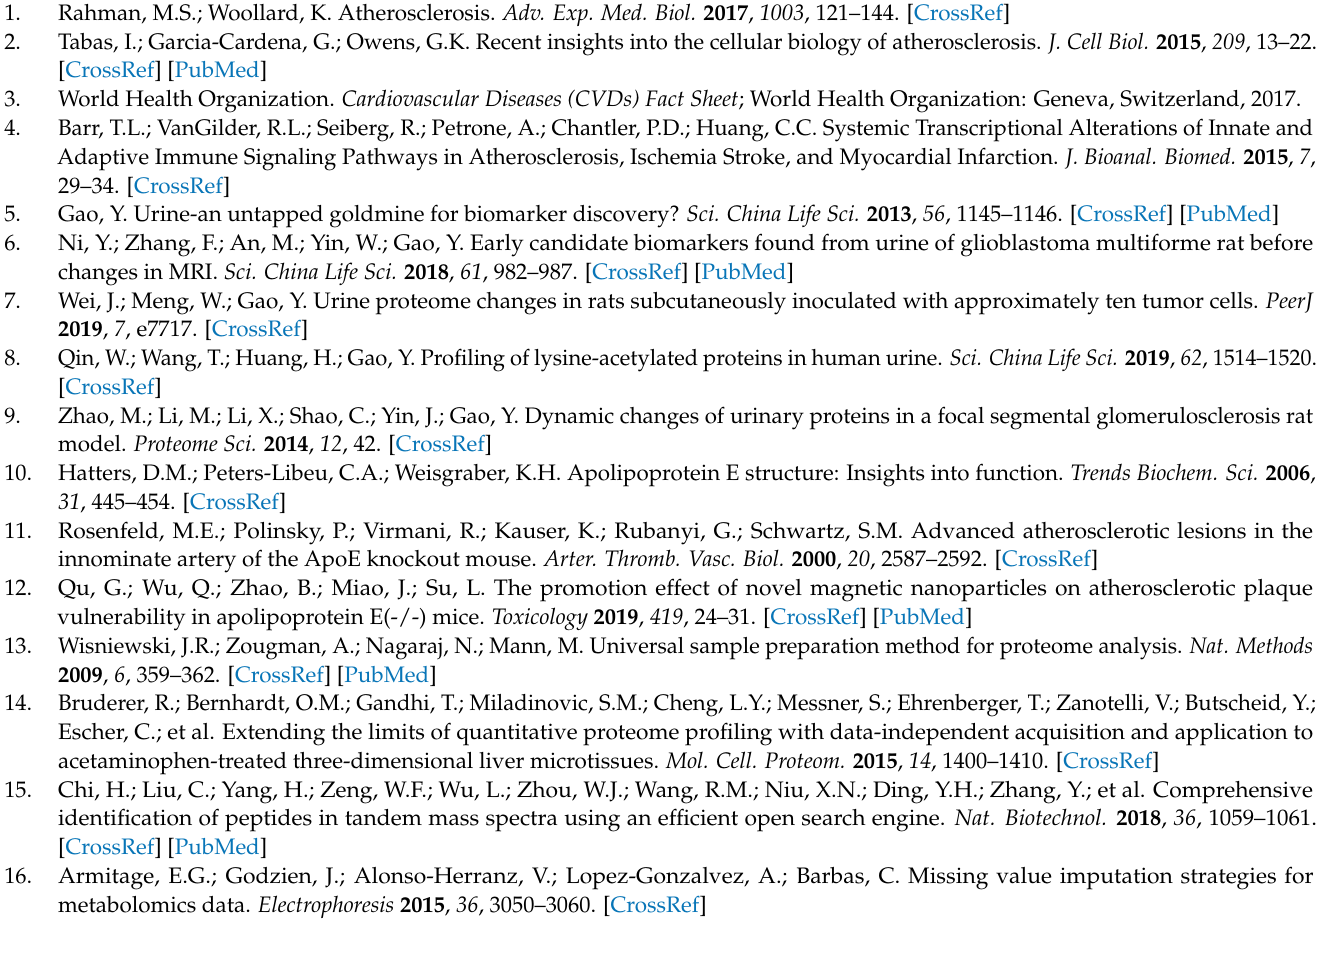
Table S6, Results of limited search of modifications; Figure S1, Venn diagram of differential proteins at different time points between the experimental group and the control group; Figure S2, Volcano plots of proteins; Figure S3, Venn diagram of differential proteins at different time points between the experimental group and the control